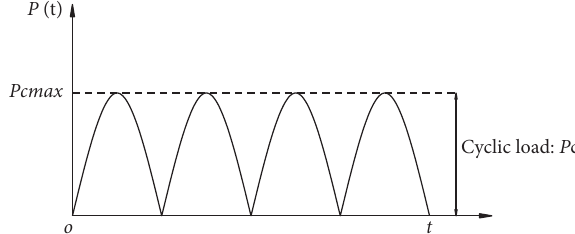
Figure 5: Testing setup.